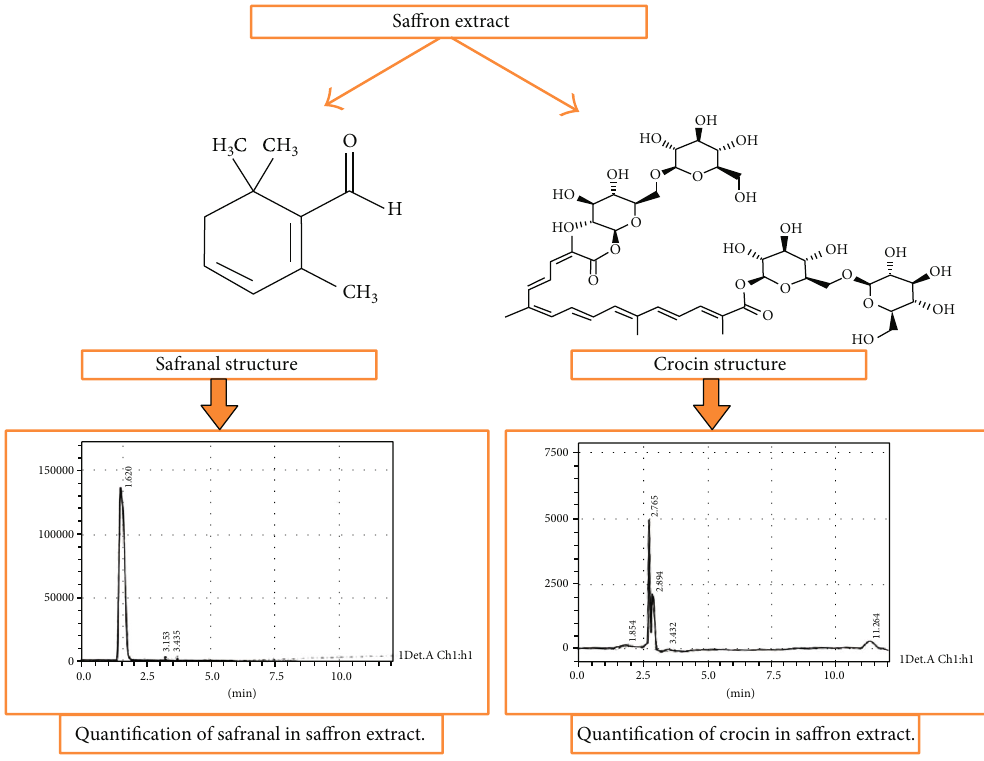
Figure 3: Concentration of crocin and safranal in sa ff ron extract. Table 1: E ff ects of nutraceutical beverage from sa ff ron with 65g/500 ml of sucrose (SEBB 1), on total antioxidant capacity, blood glucose, total protein, albumin, globulin, cholesterol, triglycerides, and phospholipid levels.